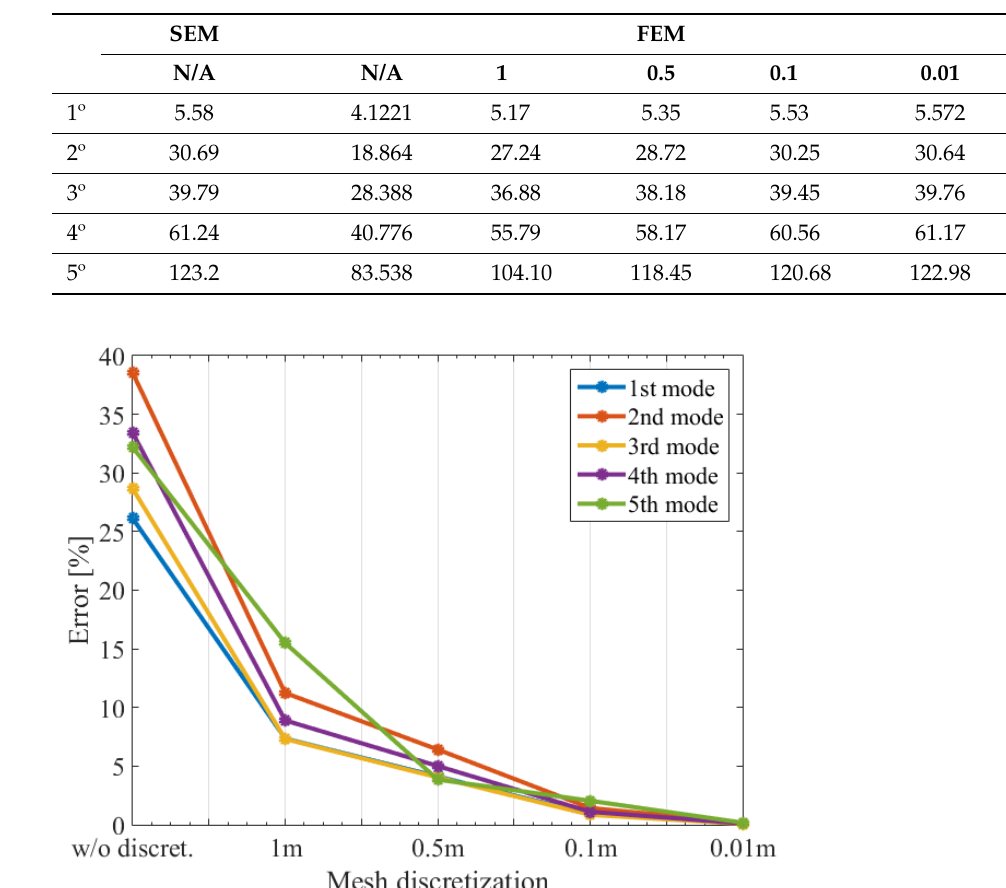
Table 3. First tower’s resonance frequencies obtained with SEM and elementary rod and FEM with different mesh discretization in meter.